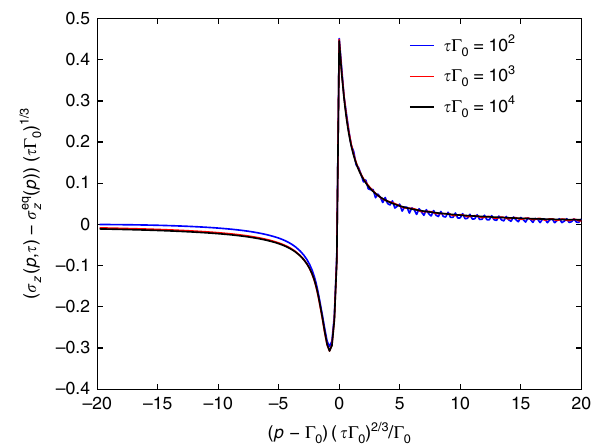
Fig. 3 Momentum resolved defect density for the non-hermitian drive. The scaling of the numerically determined momentum resolved defect density, f x ) in the near-adiabatic limit is shown for several values of τ for the full nh ( non-hermitian drive around the equilibrium